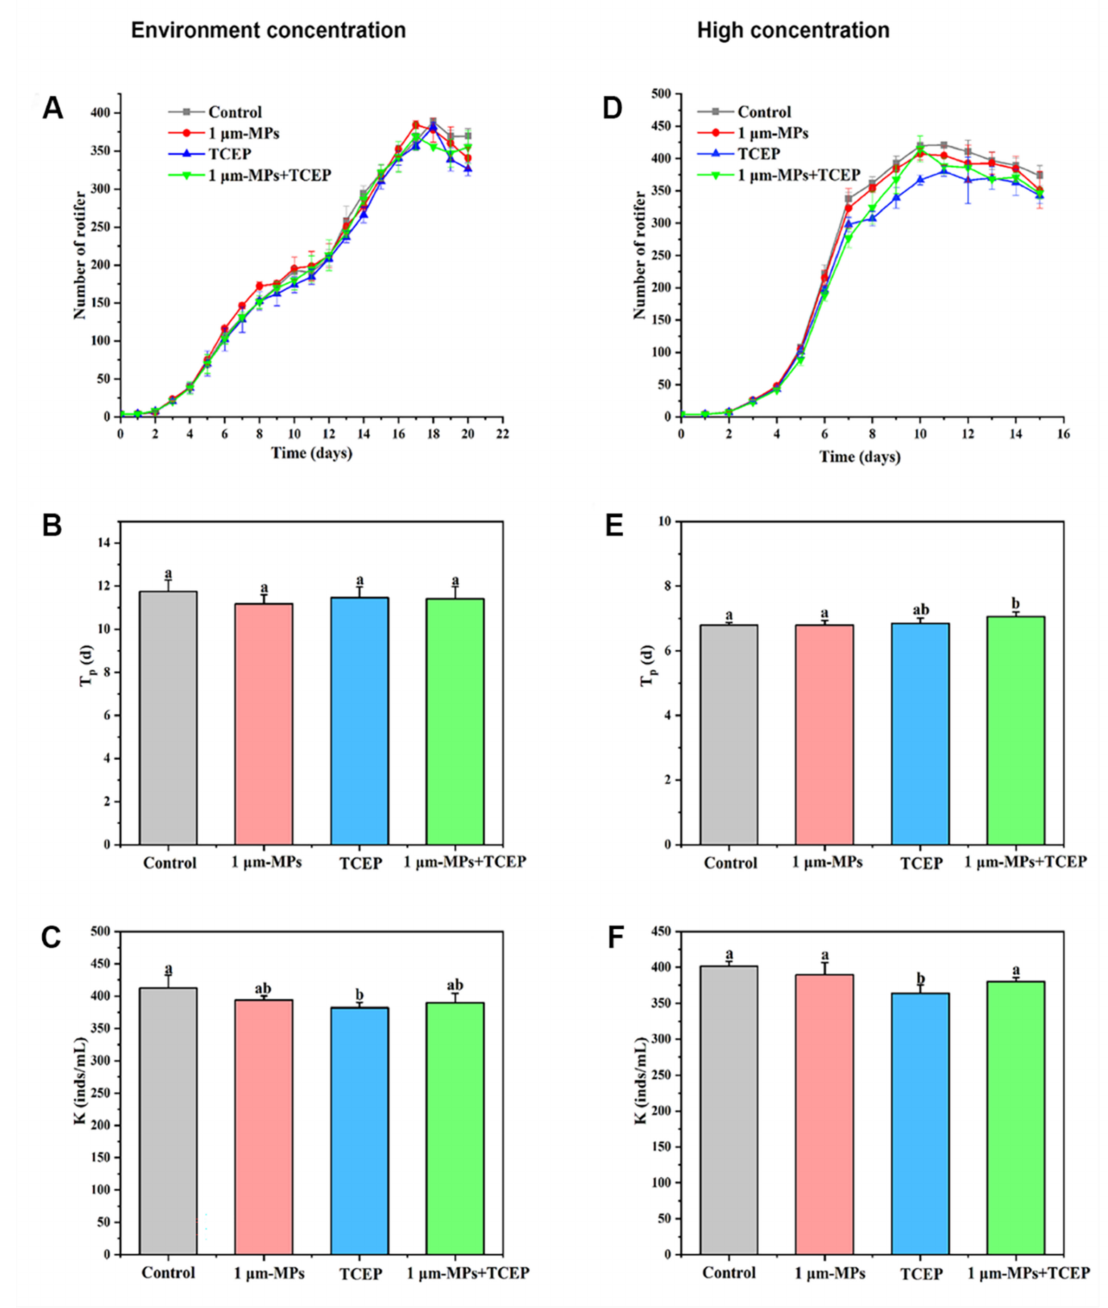
Figure 4. Population growth of B. plicatilis and its related parameters in response to 1- µ m MP and TCEP exposure at environment-related concentrations (MPs, 20 µ g/L; TCEP, 100 µ g/L) and high concentration (MPs, 2000 µ g/L; TCEP, 65 mg/L) (n = 12): ( A , D ) population growth curve; ( B , E ) inflection point of growth curve, Tp value; ( C , F ) environmental carrying capacity, K value. Data are expressed as the mean ± SD of three parallel experiments. Different lowercase letters represent significant differences between experimental groups ( p <